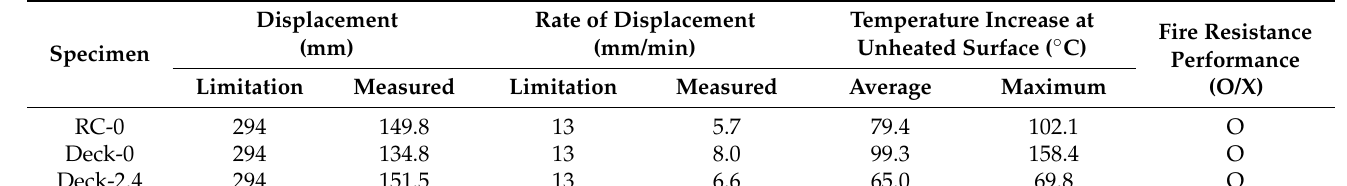
Table 7. Fire resistance performance of the deck slab.